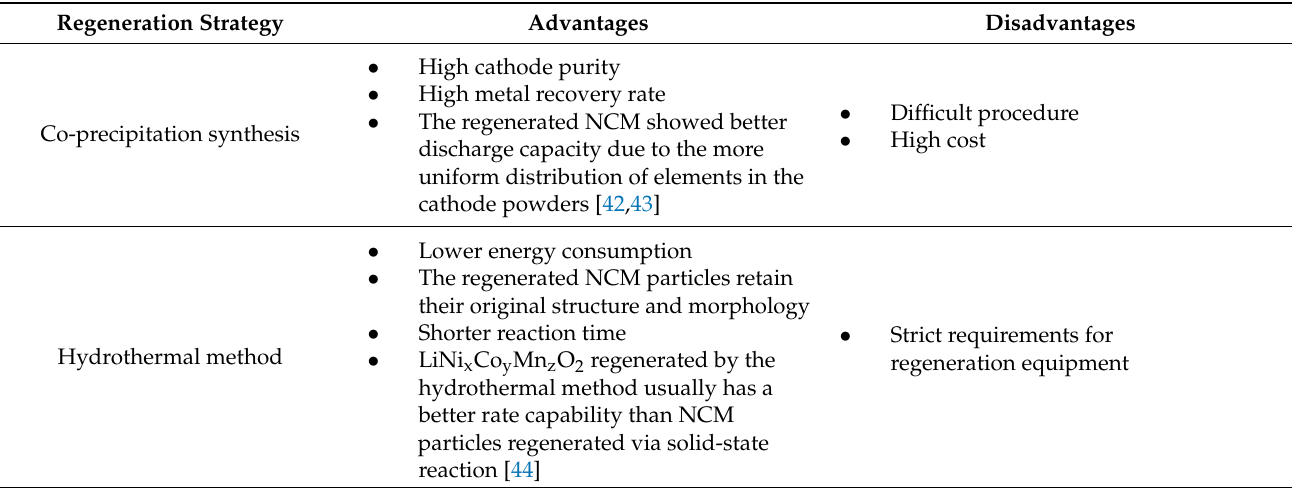
Table 1. Comparison of NCM regeneration